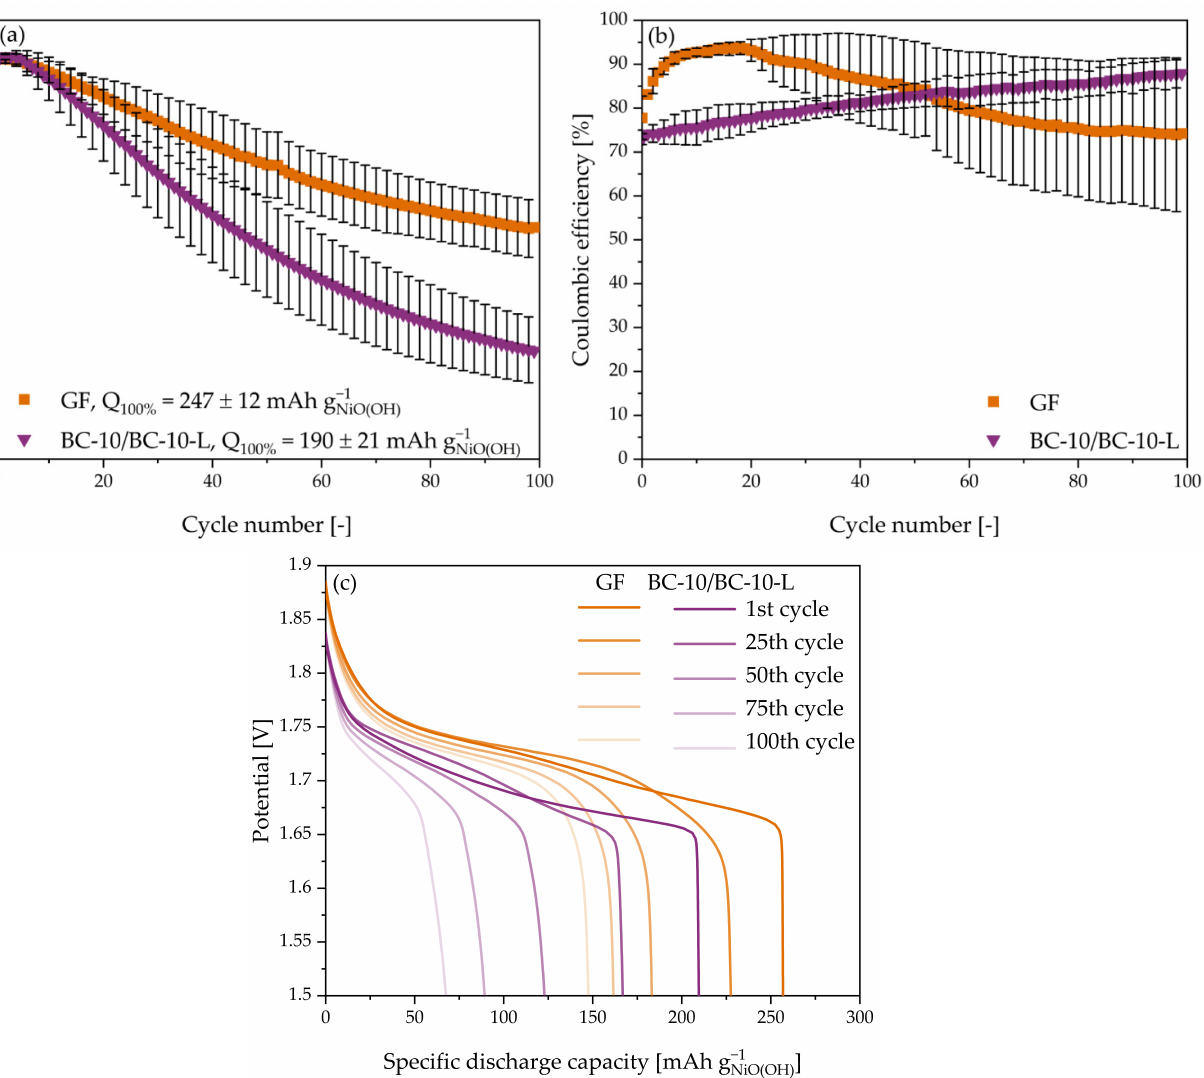
Figure 7. Comparison of commercial glass-fiber (GF) separator with combined bacterial cellulose (BC) BC-10/BC-10-L separators in a Ni-Zn battery by their ( a ) state of health, ( b ) coulombic efficiency, and ( c ) discharge voltage profiles during electrochemical cycling at